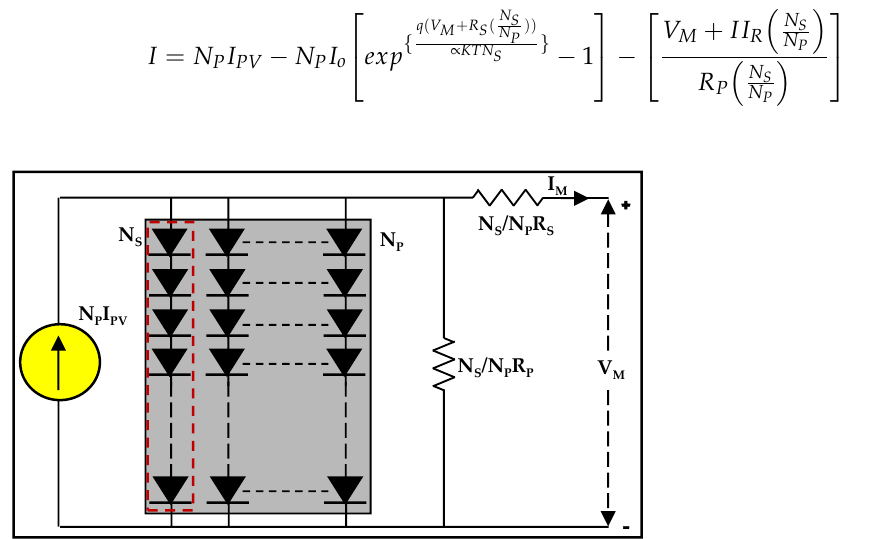
Figure 1. Circuit representation of PV modules.